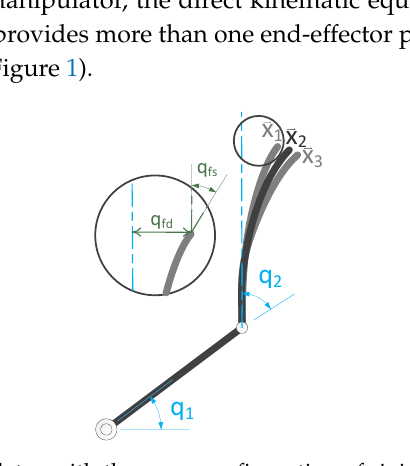
) . ( q , q f f s link tip transverse s d